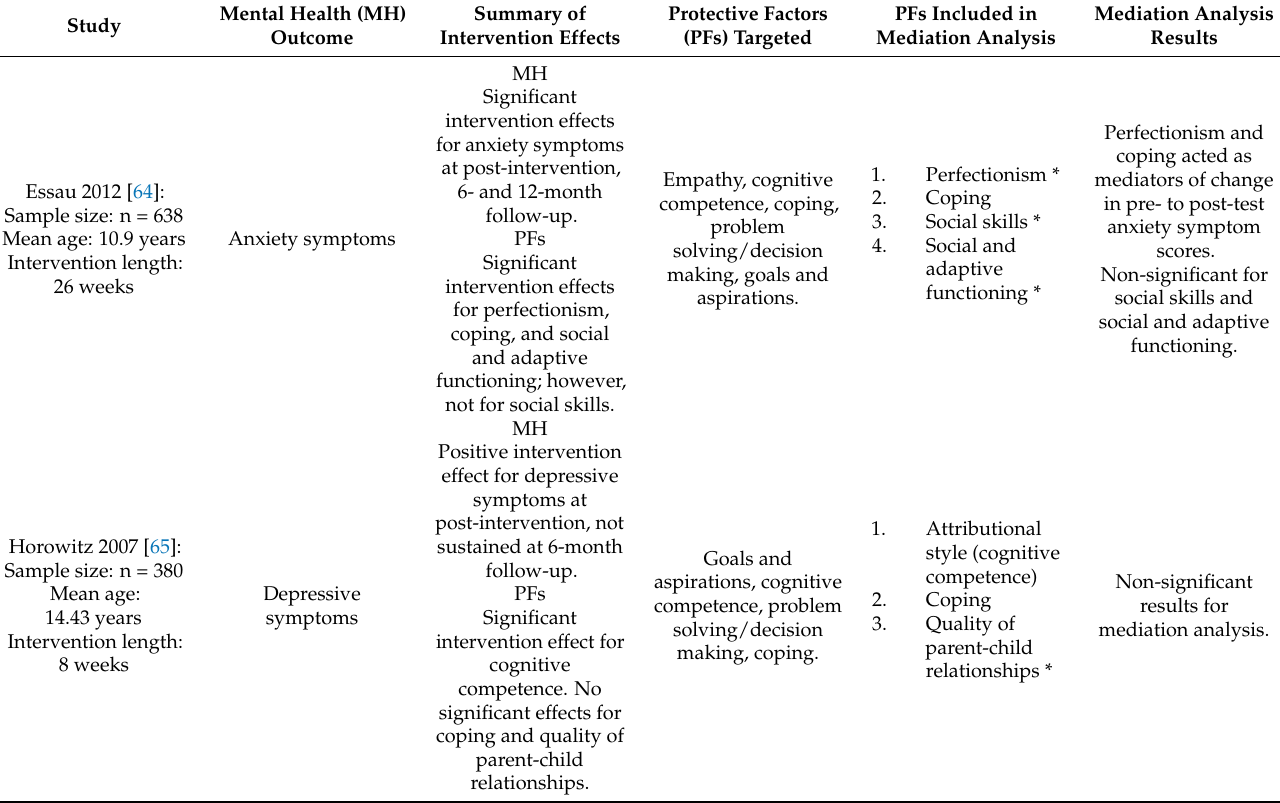
Table 4. Summary of the Dray et al. systematic review [27] included trials that incorporated mediation analysis.